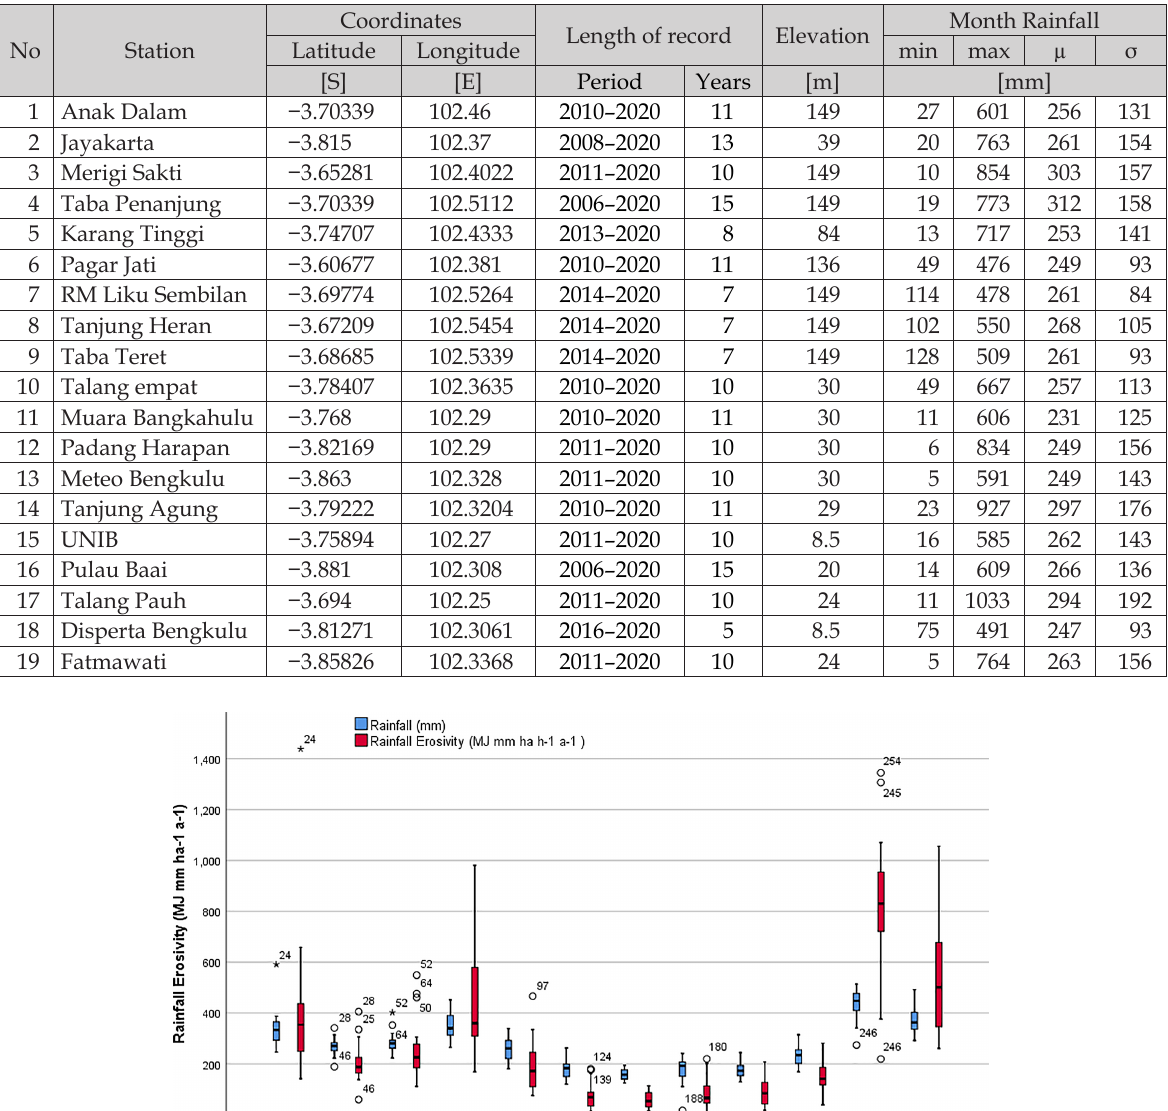
watershed.Table 1. Characteristics of gauging weather stations used in this study (acc. BMKG Station Class I Pulau